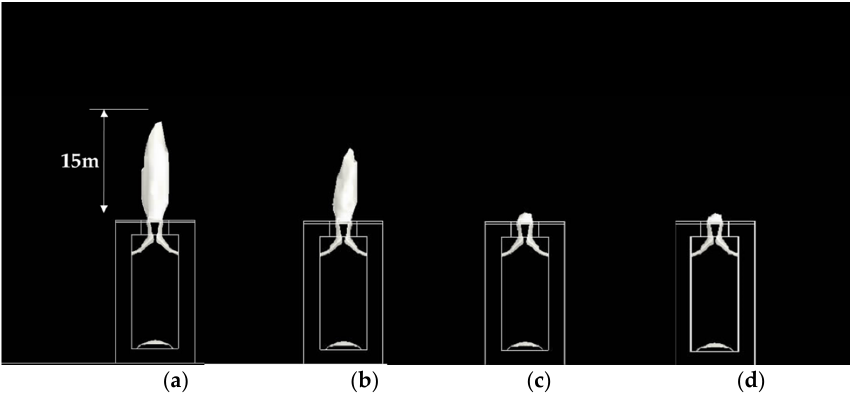
Figure 11. Effect of the external wind velocity on the scale of the visible plume for dry and wet combined operation; wind velocity of ( a ) 0 m/s, ( b ) 1 m/s, ( c ) 3 m/s, and ( d ) 5